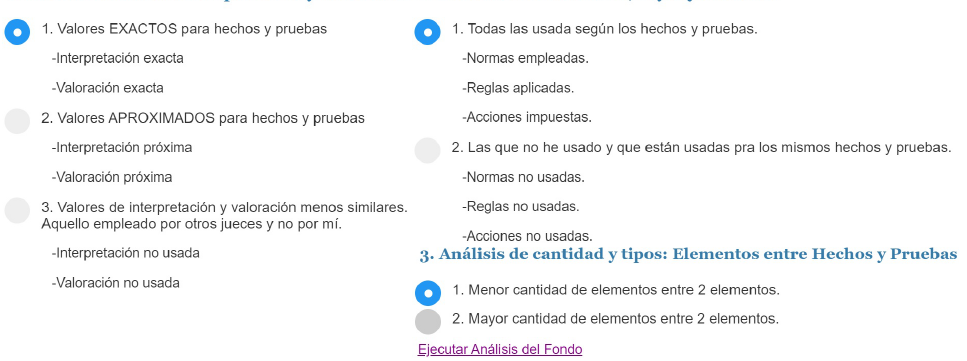
Figure 10. Graphical interface showing simulation